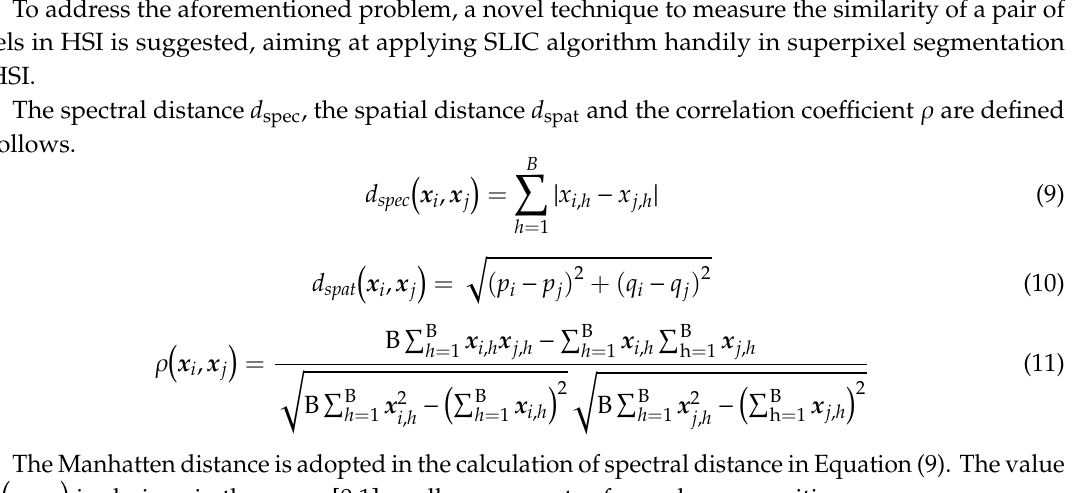
Figure 1. The spectral curves of the fifth class in Pavia University dataset.